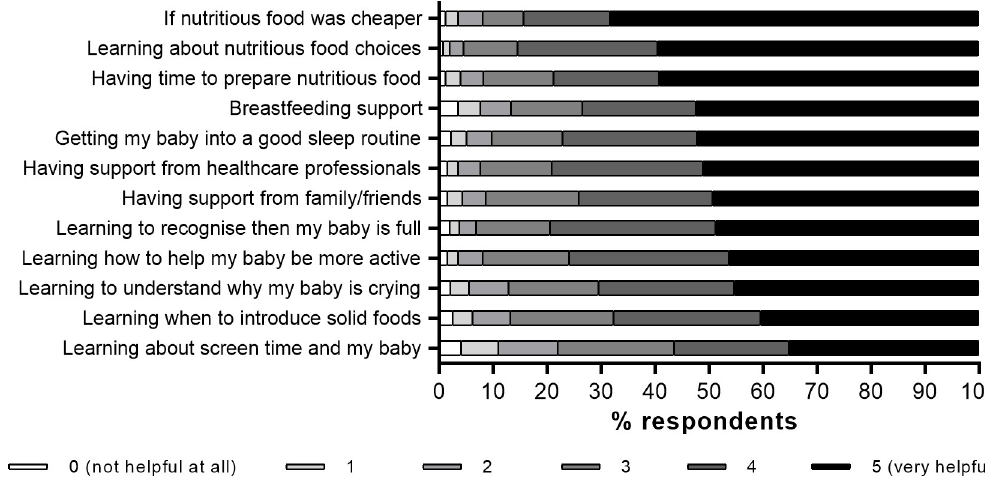
Fig 3. Distribution of participants’ ratings in response to suggested support that might help if they were told their baby was at risk of early childhood obesity (n = 1,792).